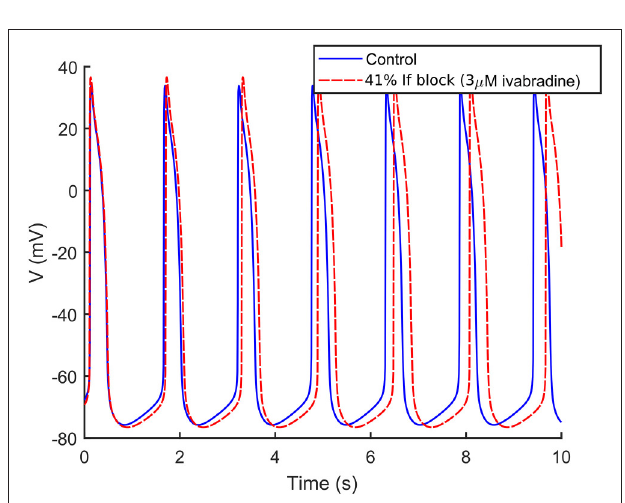
FIGURE 8 | Effect of 3 µ M ivabradine on the spontaneous APs. Administration of ivabradine (in dashed red) slightly slows down the rate of the spontaneous APs in comparison to control (in solid